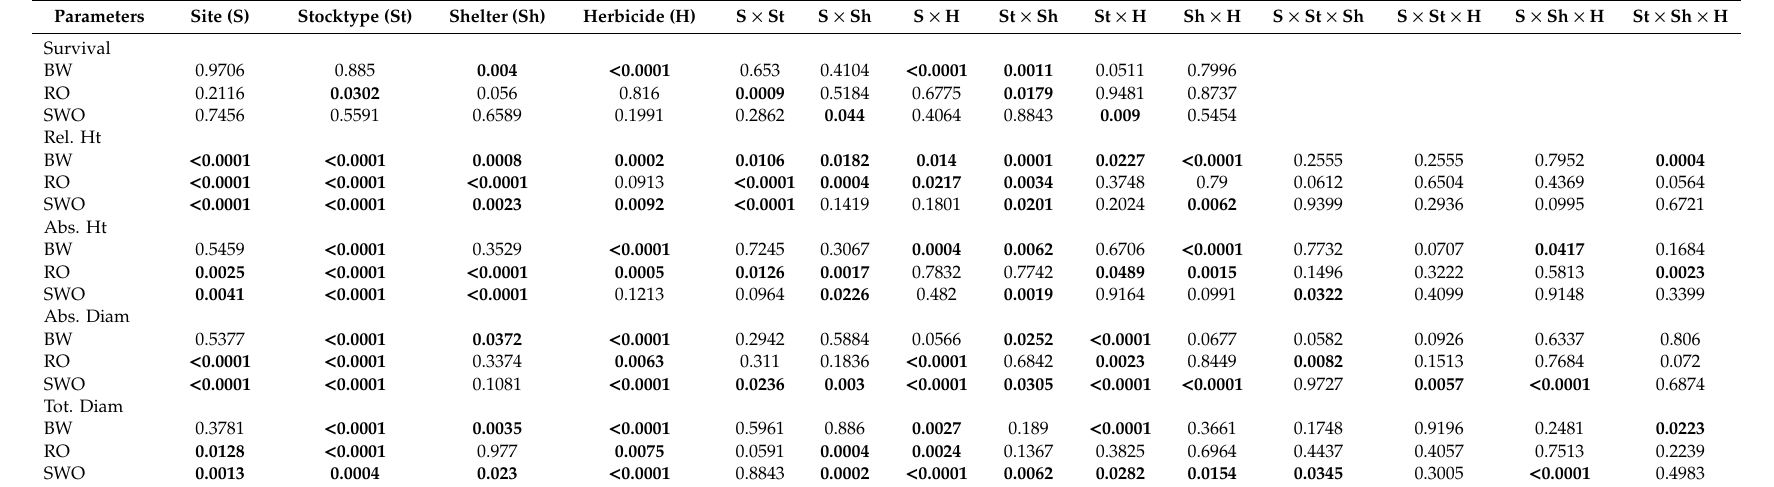
Table 3. ANOVA results for second year field